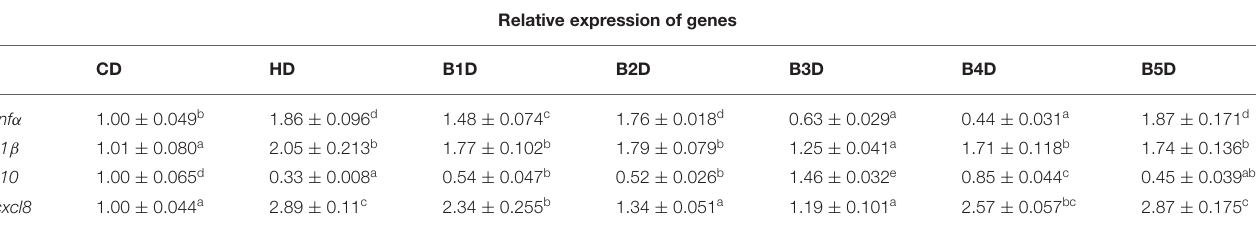
TABLE 3 | The relative expression of genes associated with inflammatory cytokines and chemokines in the liver. Relative expression of